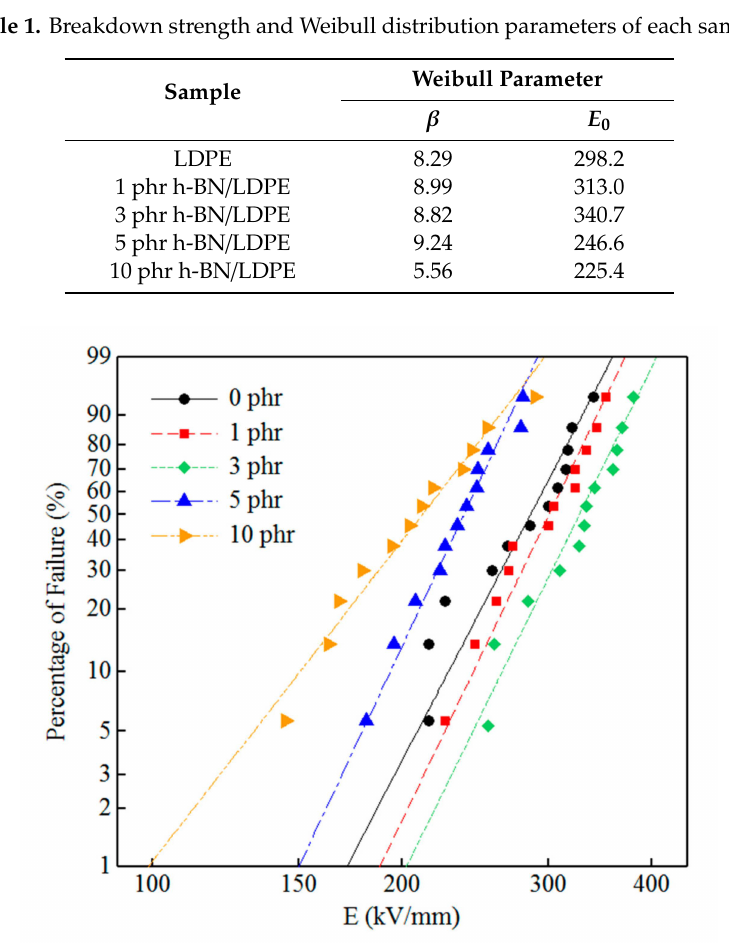
Figure 9. Weibull distribution of DC breakdown strength of LDPE and h-BN / LDPE composites with various h-BN filler